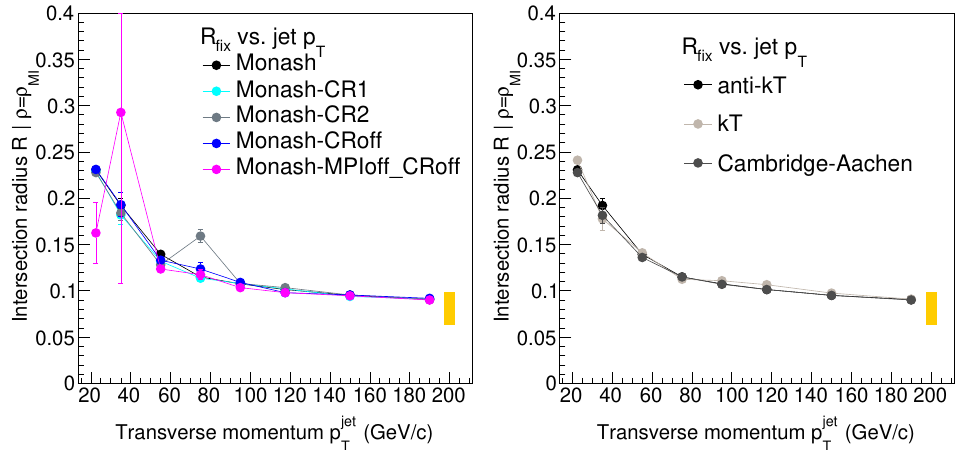
Figure 6. The evolution of R fix with the p jet reconstruction algorithms ( right